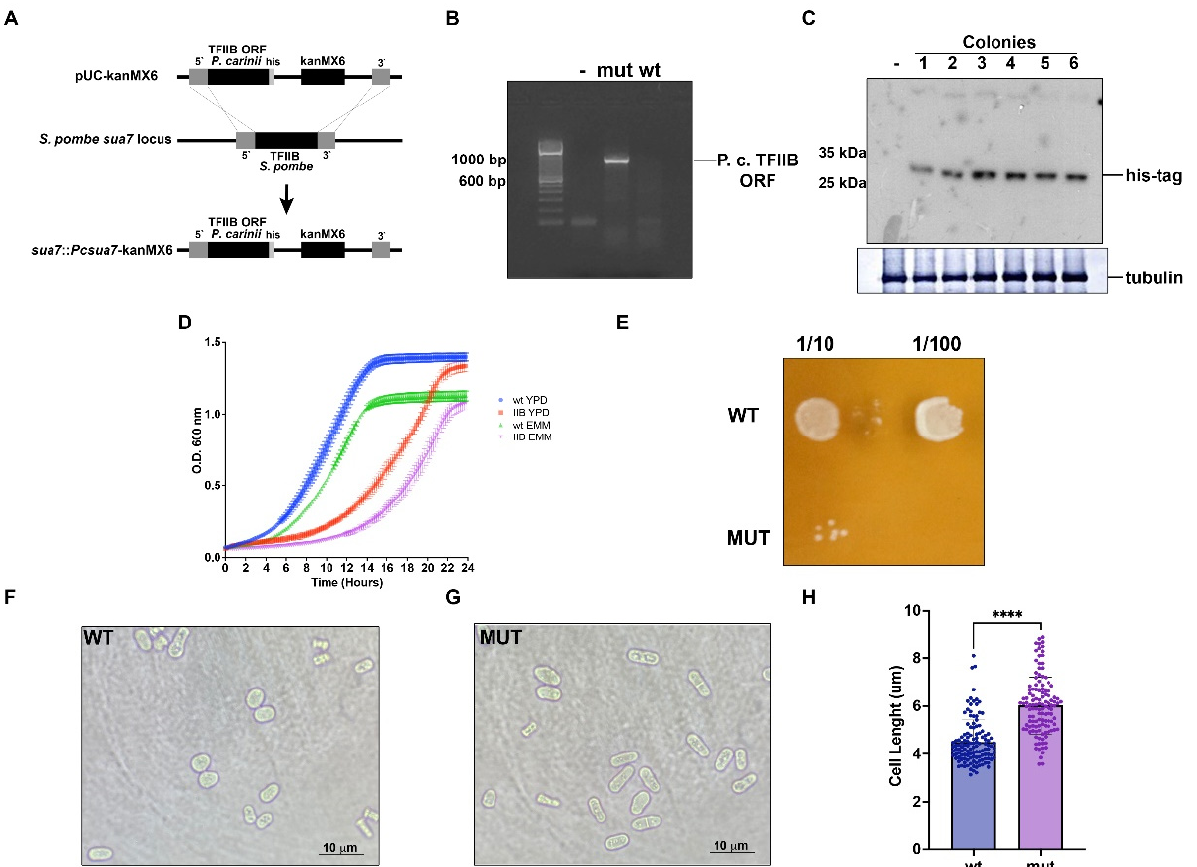
Figure 2. Characterization of a sua7::Pcsua7-kanMX6 strain. ( A ) Schematic representation of the construction used for S. pombe TFIIB (SpIIB) deletion and replacement by P. carinii TFIIB (PcIIB). The construct was made as described in Materials and Methods and amplified by PCR. The PCR products were used to transform S. pombe cells and simultaneously delete and replace the endogenous SpIIB (sua7) gene by a cDNA encoding the PcIIB. Resulting strain was named sua7::Pcsua7-kanMX6. ( B ) PCR analysis of genomic DNA from mutant and wild-type cells, indicating the presence of the P. carinii TFIIB ORF. ( C ) Resulting colonies were resistant to G148 antibiotic, grew in liquid cultures in YPD media and analyzed further by the presence of the His-tagged PcIIB by Western blot. All analyzed colonies from 1–6 possessed the His-tagged PcTFIIB and colony 3 was chosen for further studies—indicates wild-type cell proteins. Bottom panel indicates the presence of tubulin as internal control. ( D ) Wild-type cells (WT) cells and sua7::Pcsua7-kanMX6 (IIB) cells containing PcIIB were grown during 24 h in EMM and YPD liquid media and the growth data were recorded. ( E ) Microdilution analysis of colonies from wild-type and mutant strains; 1/10 and 1/100 dilution from saturated cultures growth in YPD medium were plated in YPD agar. Colonies were grown at 30 °C and were evaluated after 48 h. Wild-type ( F , WT) and mutant ( G , MUT) cells grown in YPD medium were observed by microscopy using a magnification of 1000X to evaluate their shape. ( H ) Quantification of cell length. Analyses were performed measuring the length of 25 cells per field using 1000X of magnification and 5 fields. **** indicates p < 0.0001.